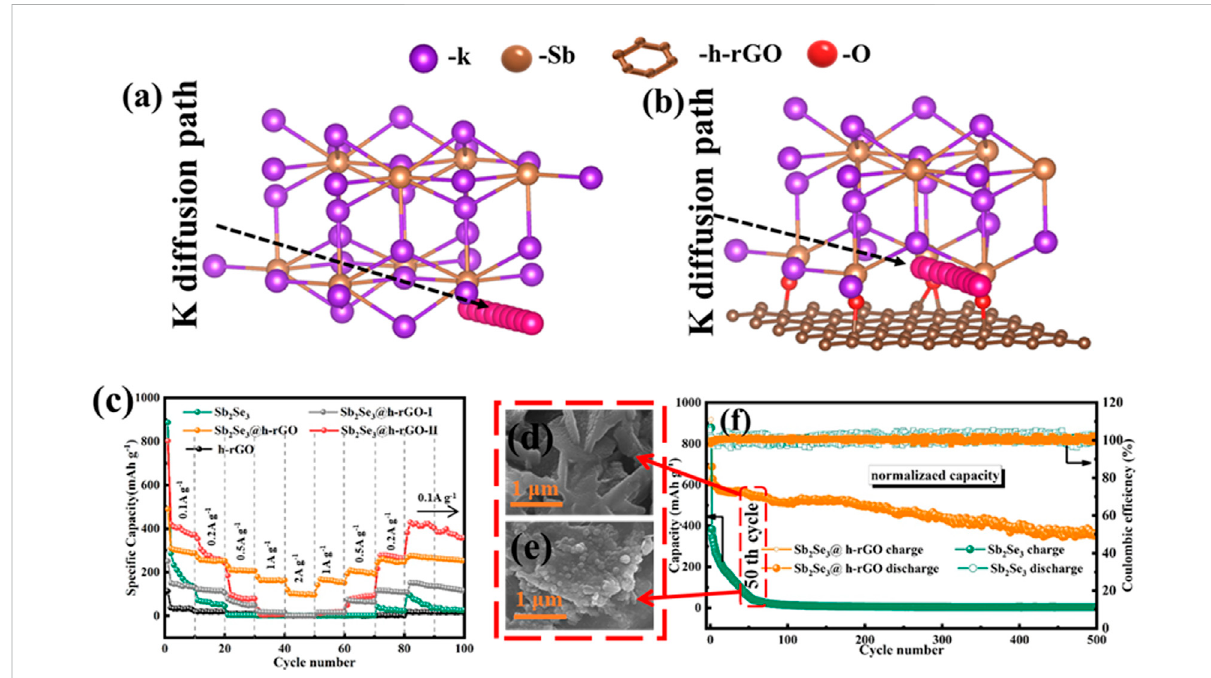
FIGURE 8 K diffusion paths in (A) K 3 Sb@graphene and (B) K 3 Sb model. (C) Rate capability for free-standing Sb 2 Se 3 @h-rGO electrodes. SEM images of (D) free-standing Sb 2 Se 3 @h-rGO electrode and (E) Sb 2 Se 3 powder electrode after 50 repeated cycles. (F) Cycling performances of the free-standing Sb